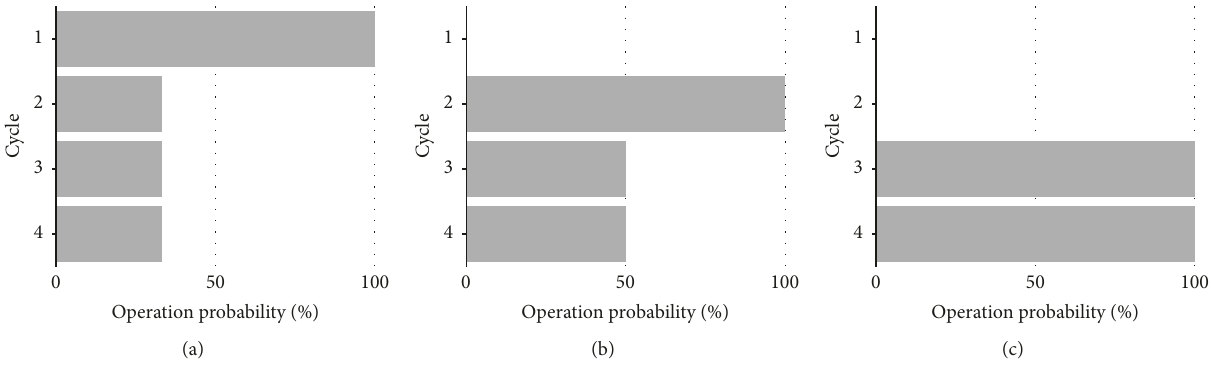
Figure 4: Distribution graphs for a cycle 1 assignment (a), for a cycle 2 assignment (b), and for a cycle 3 assignment (c) of operation